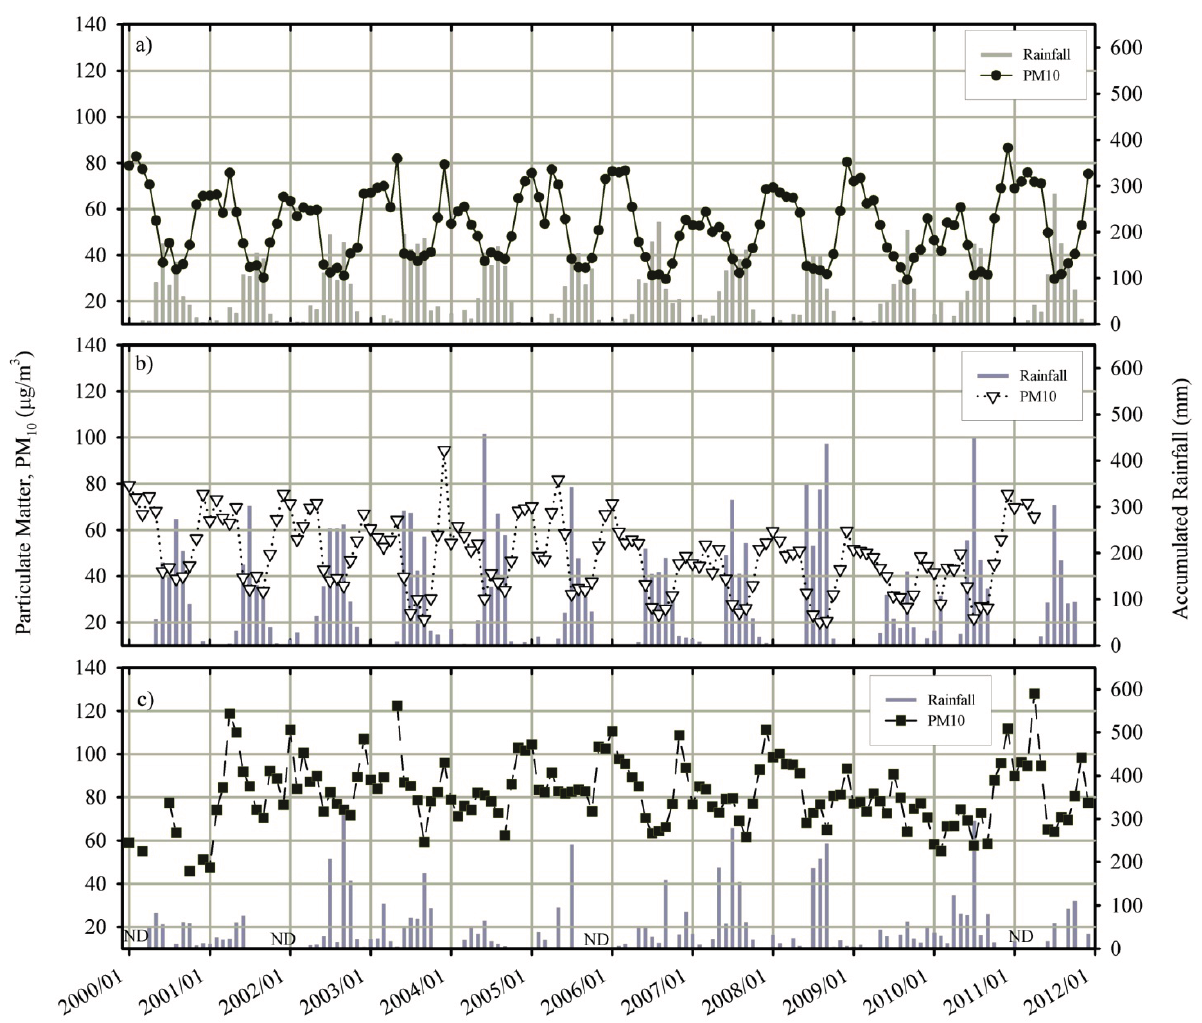
Figure 13. Temporal variation of monthly averages of PM accumulated monthly rainfall in the ( a ) MCMA, ( b ) GMA, and ( c )